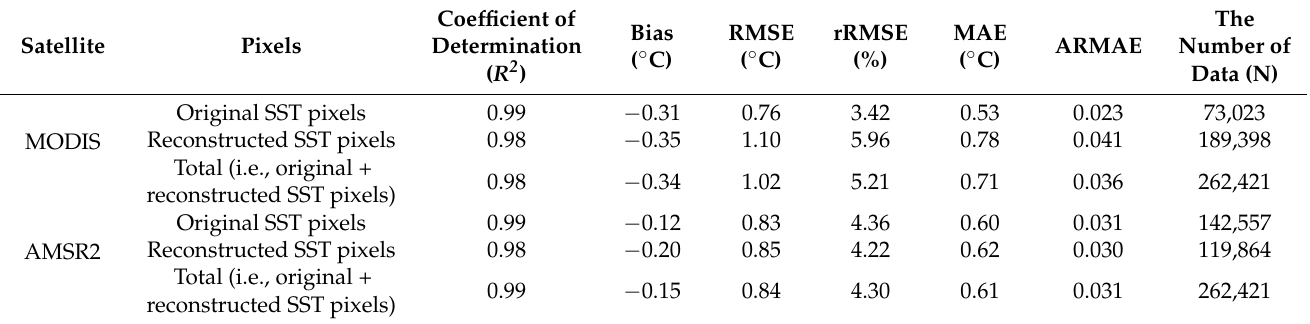
Table 5. Accuracy of the original and reconstructed SST pixels for MODIS and AMSR2 when compared to the in situ